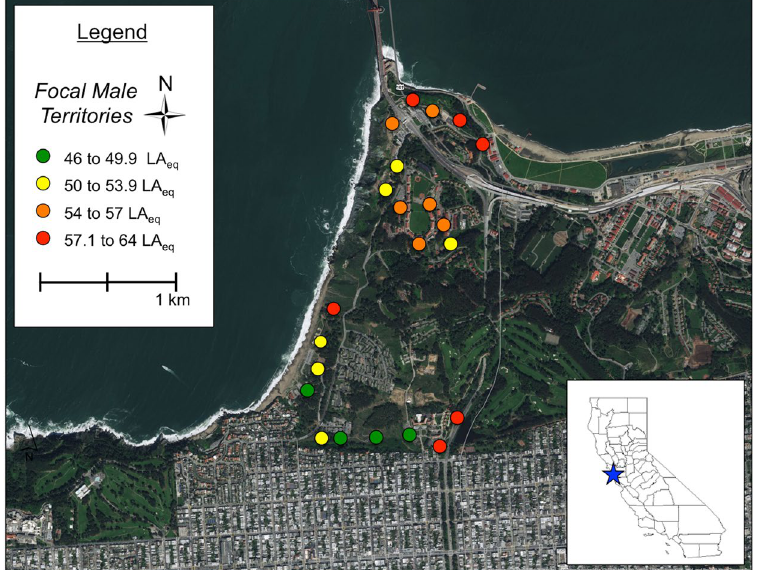
Figure 2. Map of focal male territories in the Presidio, San Francisco, California, USA. Circles denote an individual male and the average territory noise across three measurements. Map created in ArcMap 10 (ESRI, Redlands, CA, USA) with ESRI world imagery (Sources: ESRI, DigitalGlobe, GeoEye, Earthstar Geographics, CNES/Airbus DS, USDA, USGS, AeroGRID, IGN, and the GIS User